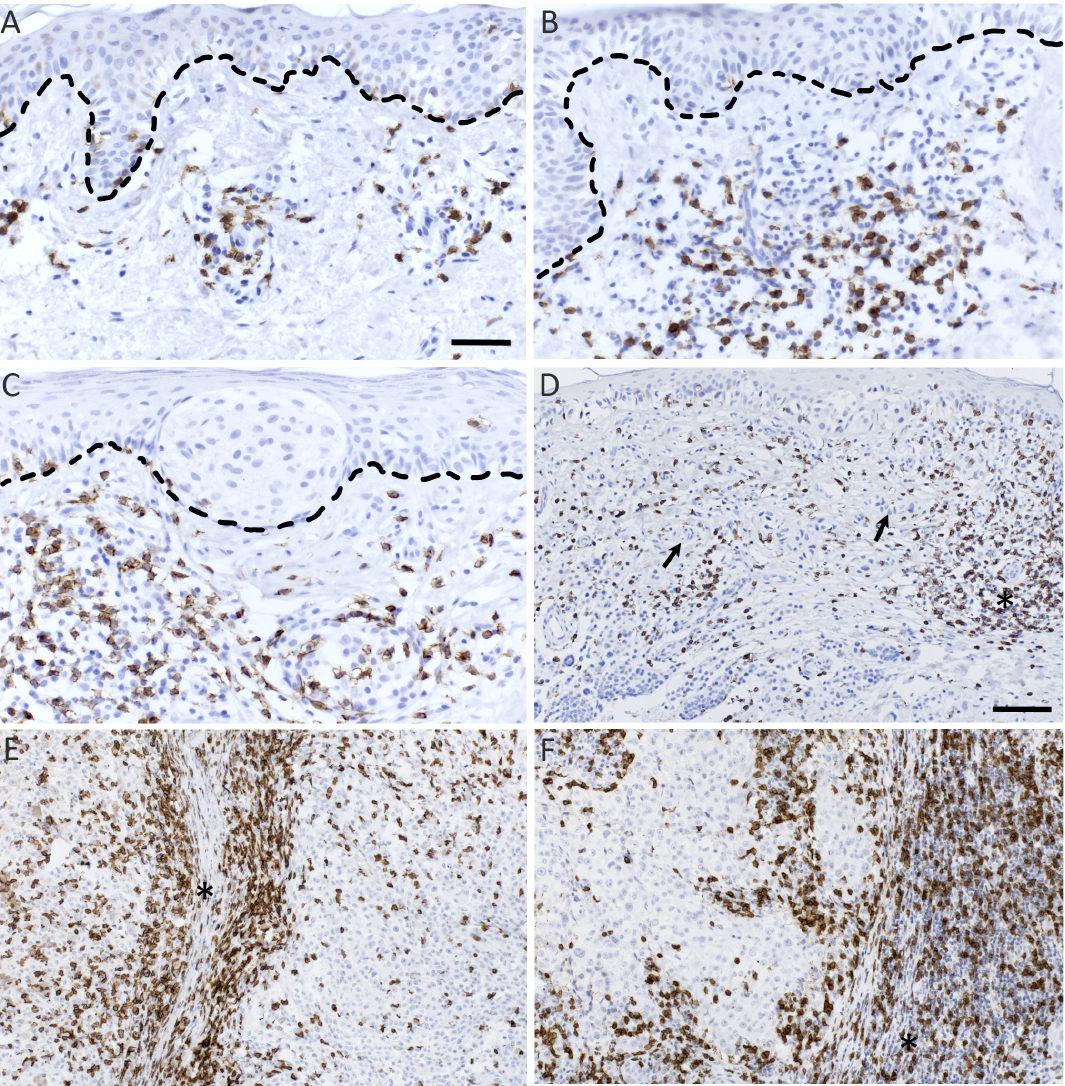
Figure 1. Representative immunohistochemical stainings of CD8+ lymphocytes (positive staining shown in brown and counterstained nuclei in blue). Immunohistochemical stainings of CD8 in benign ( A ) and dysplastic nevi ( B ), in situ melanoma ( C ), superficial (Breslow’s depth < 1 mm, ( D )) and deep melanomas (Breslow’s depth > 4 mm, ( E )) and lymph node metastasis ( F ). The dashed line in ( A , B ) defines the epidermis in benign and dysplastic nevi, respectively, and the dashed line in ( C ) marks the tumor–stroma borderline in in situ melanoma. The asterisks in ( D – F ) indicates the stromal tumor compartment, and black arrows in ( D ) point to tumor cells. Scale bar is 50 µ m in ( A ) (and applies across ( A – C ), which all have × 200 magnification) and 100 µ m in ( D ) (which applies across ( D – F ), which have all the same × 100 magnification),